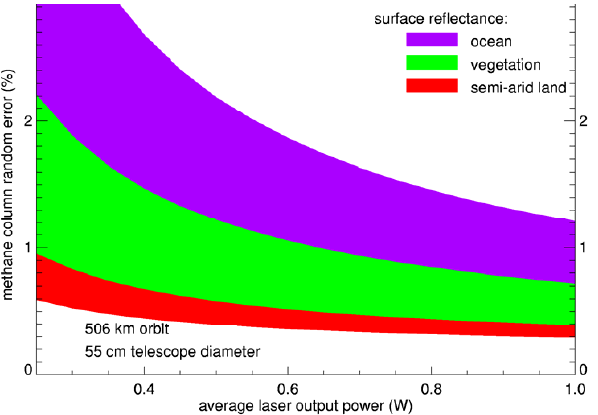
Fig. 8. Measurement precision as function of telescope diameter and surface reflectance (similar to Fig. 7). The MERLIN baseline with 0.55m and 0.1sr − 1 yields a precision of 0.8%.